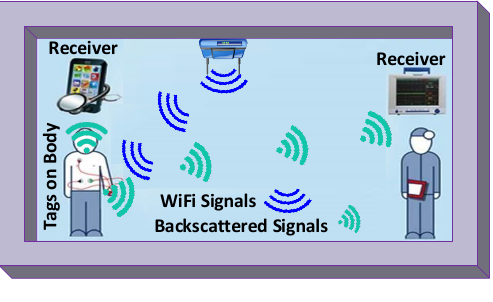
Figure 43. BackCom in the bio-medical field.